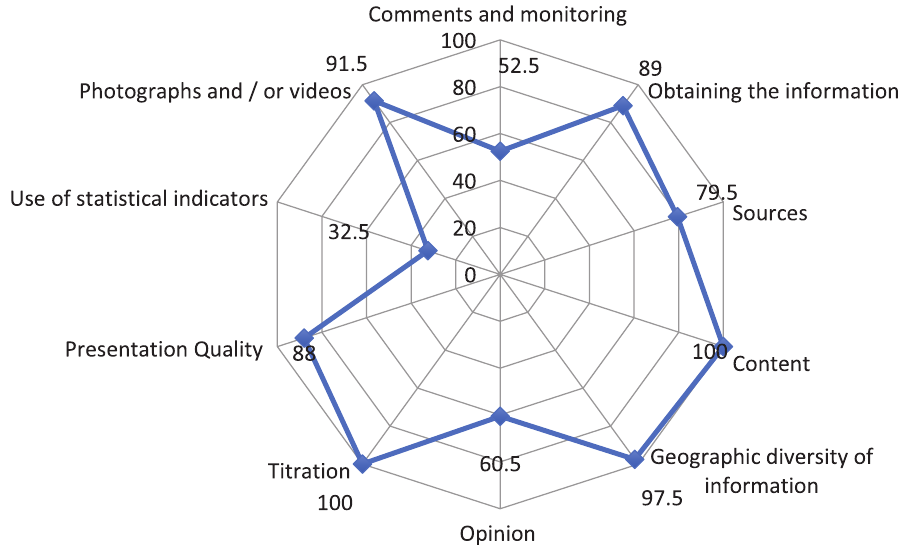
Figure 1. Average rating (in percent) of dimensions of digital native media in Latin America.